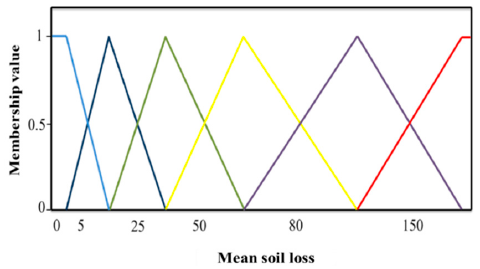
Figure 3. Fuzzy membership functions for soil loss classification.